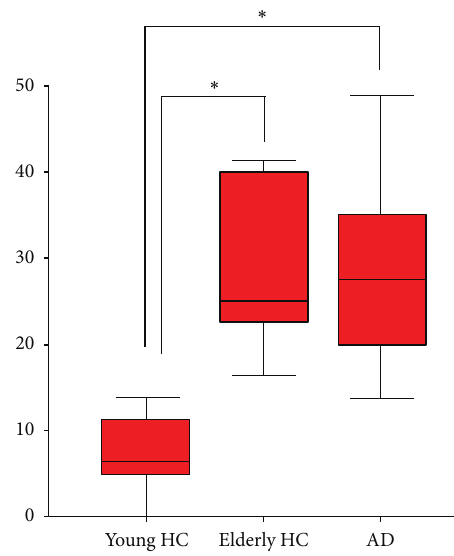
Figure 1: Hearing level of three groups. HC: healthy control; AD: Alzheimer’s disease. There is a significant group effect (one-way ANOVA, 𝑃 < 0.01 ). A post hoc test indicated the group differences ( ∗ 𝑃 < 0.05